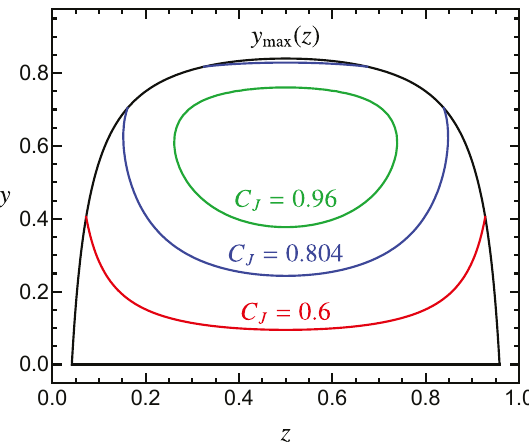
Figure 14 . Three-particle phase space (black lines) showing contour lines for the C-jettiness event shape in red ( C J = 0 : 6), blue ( C J = 0 : 804) and green ( C J = 0 : 96). The plot uses the numerical value ^ m = 0 :